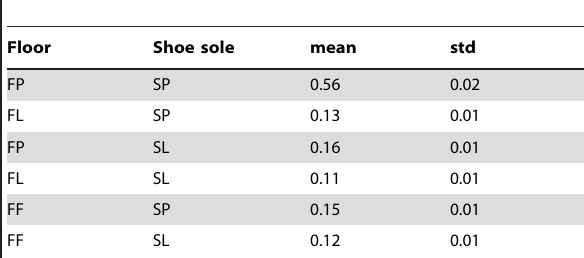
Table 1. COF values under shoe-floor